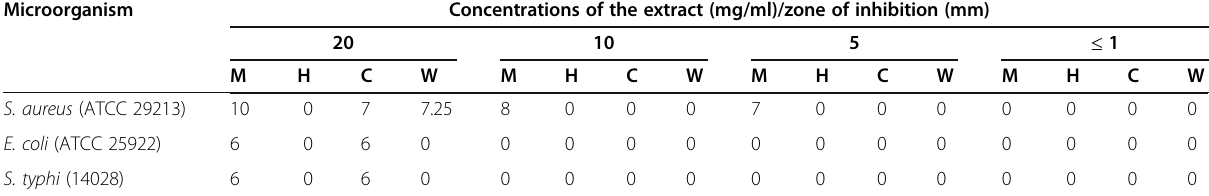
Table 3 Antibacterial activity of T. dodoneifolius on the test bacteria